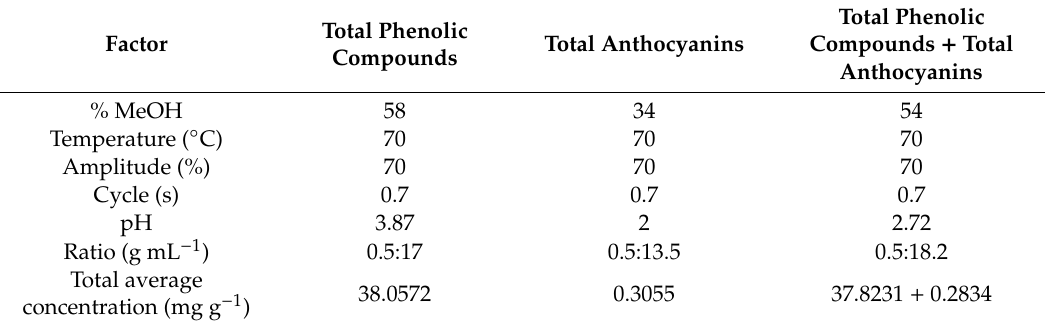
Table 3. Individual and simultaneous optimal conditions for the extraction of each type of compounds. Total Phenolic Factor Total Anthocyanins Compounds